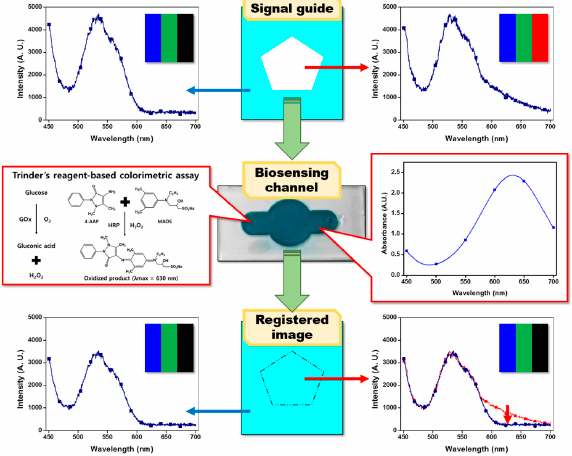
Figure 2. Illustration of the principles used in the newly developed optical biosensing system. The signal guide consists of red, green, and blue light at a certain ratio, and the area surrounding the polygons contains only green and blue light. After locating the biosensing channel that has the blue chromogen on the signal guide, we converted the color of signal guide into blue owing to absorption of the red light by